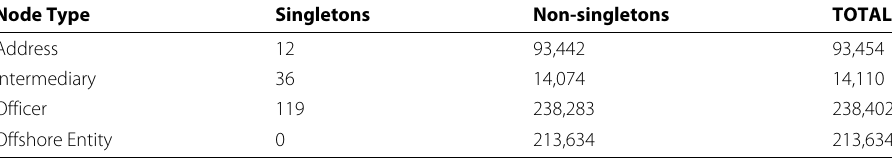
Table 1 Some node statistics on the global Panama multi-network Node Type